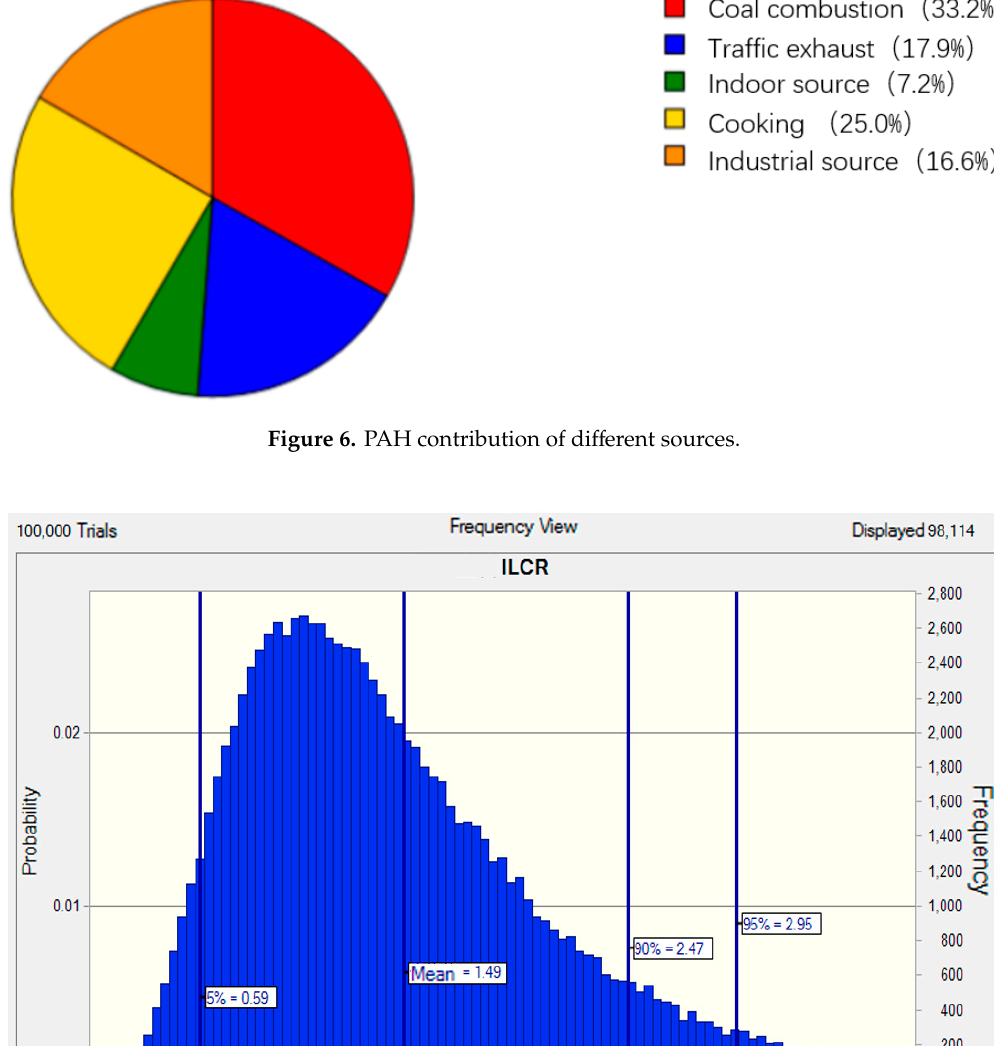
Figure 5. Results of positive matrix factorization.